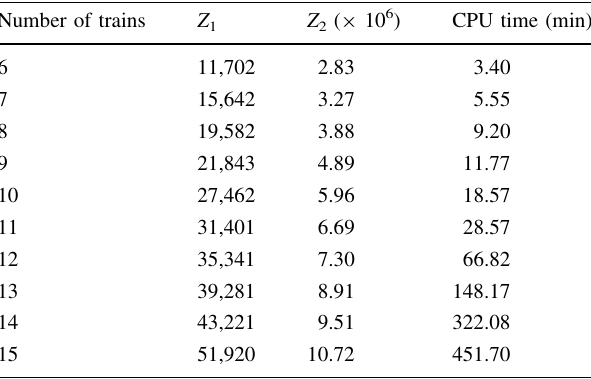
Fig. 7 The first and second objective function value in different values of u